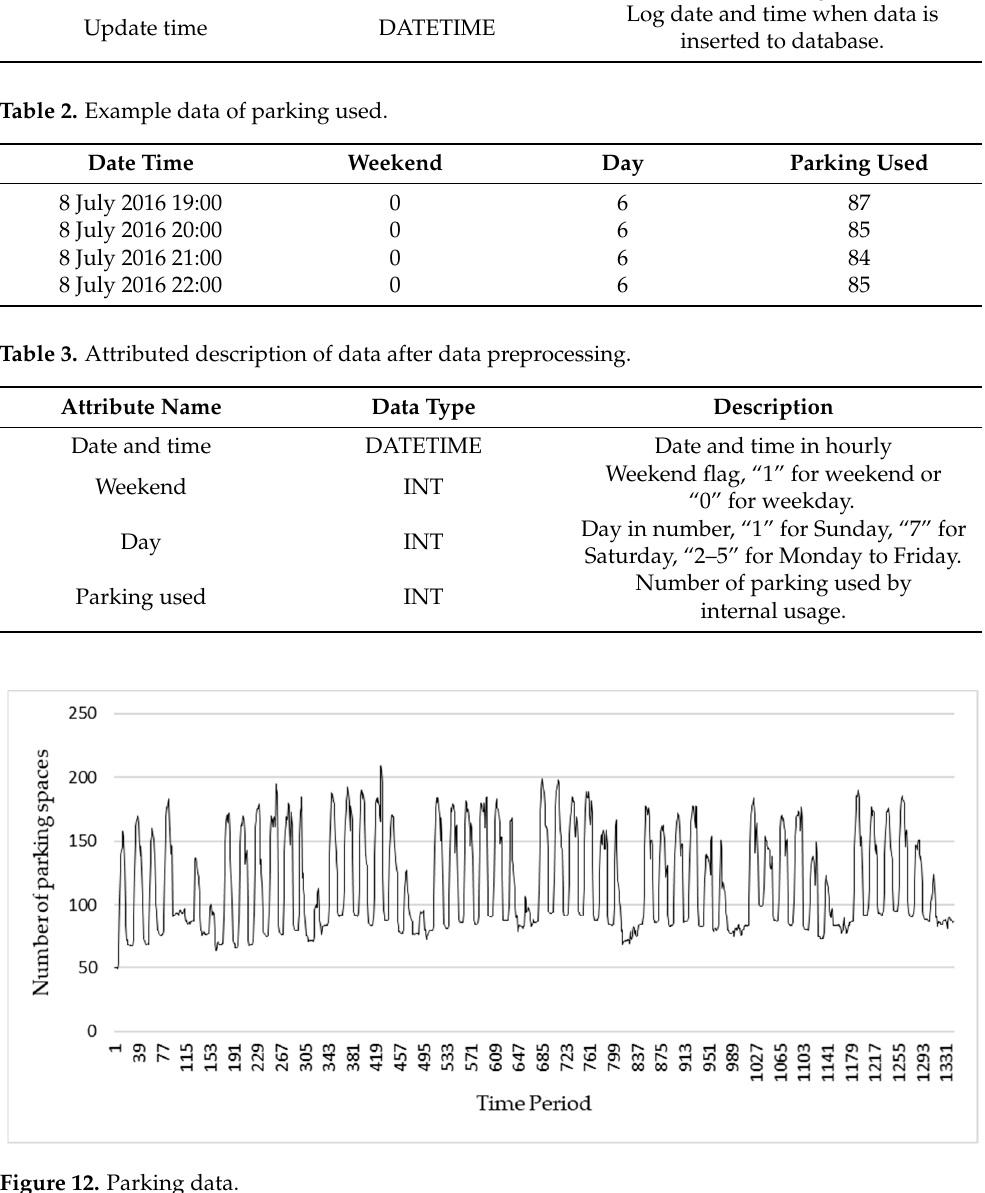
Figure 12. Parking